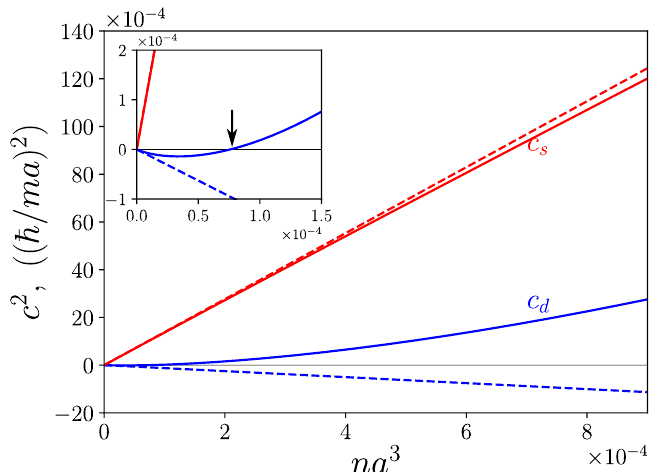
Figure 1: Square of the speed of sound as a function of the gas parameter, evaluated for the characteristic value δ g / g = − 0.2. The blue (bottom) and red (upper) lines are the density and spin sound velocity, respectively. Dashed lines, Bogoliubov theory, Eq. (7). Solid lines, improved theory, Eq. (11). Inset: zoom of the low-density region in the vicinity of the spinodal point, shown by the black